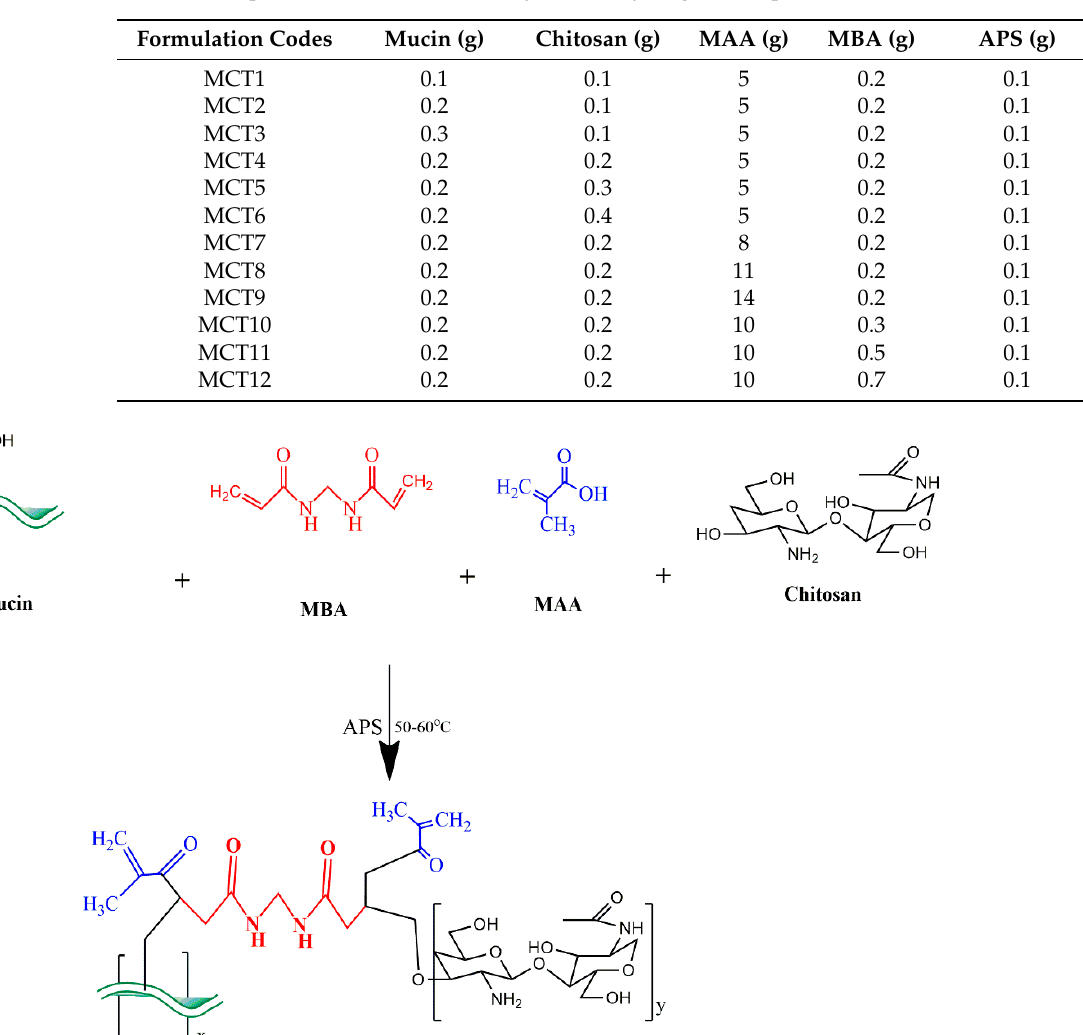
Table 8. Composition of MU-CHI-Co-Poly (MAA) hydrogel microparticles (MCT1–MCT12). Formulation Codes